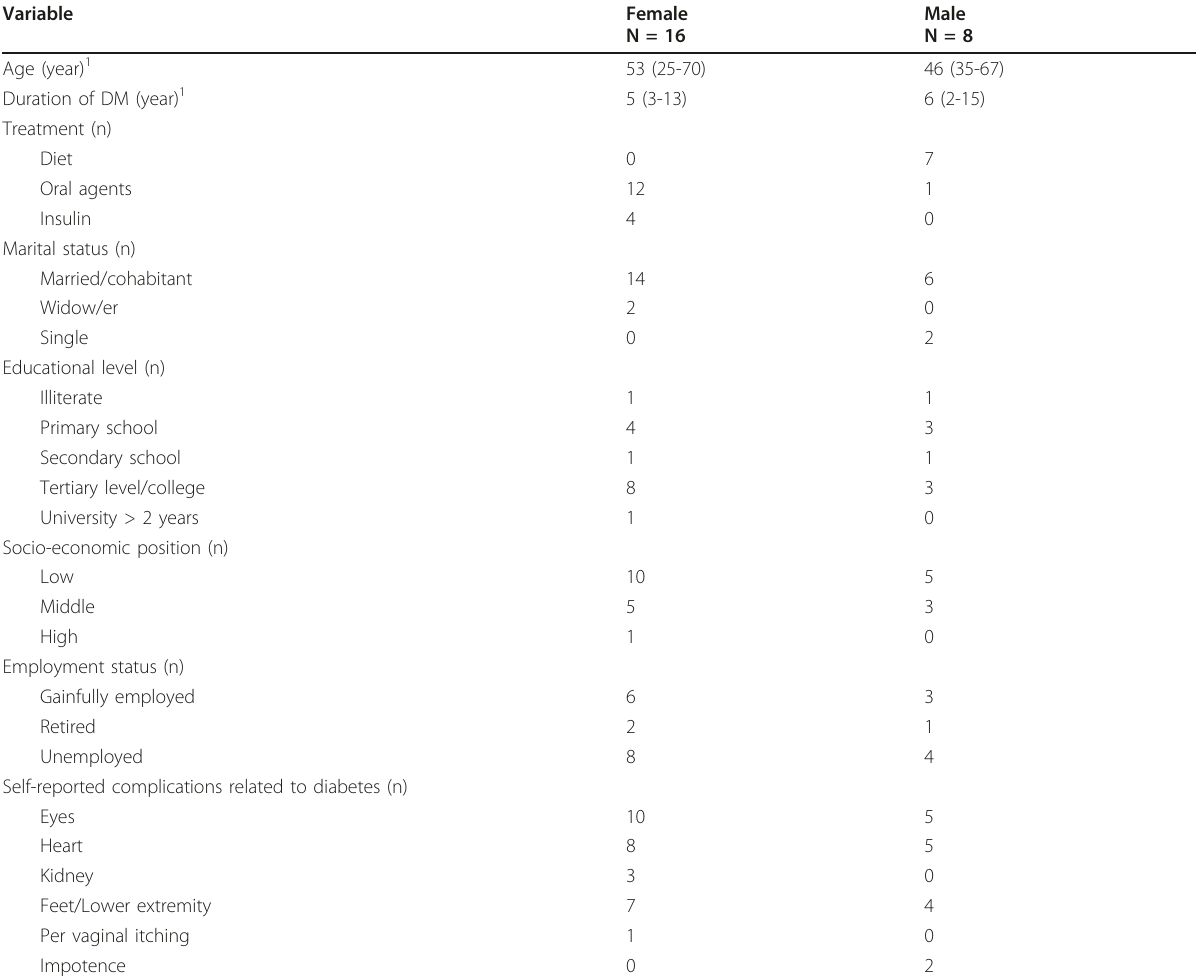
Table 1 Characteristics of the studied